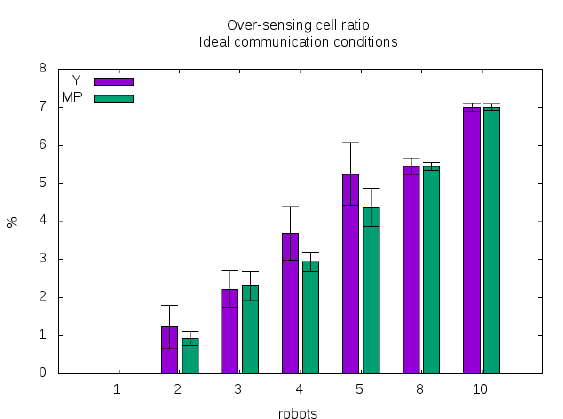
Figure 16. Over-sensing ratio (OSR) under ideal communication conditions. This shows how as fleet size increases the trend of OSR is upward as well. This is expected since the more robots sensing the environment the higher the probability of simultaneously sensing the same